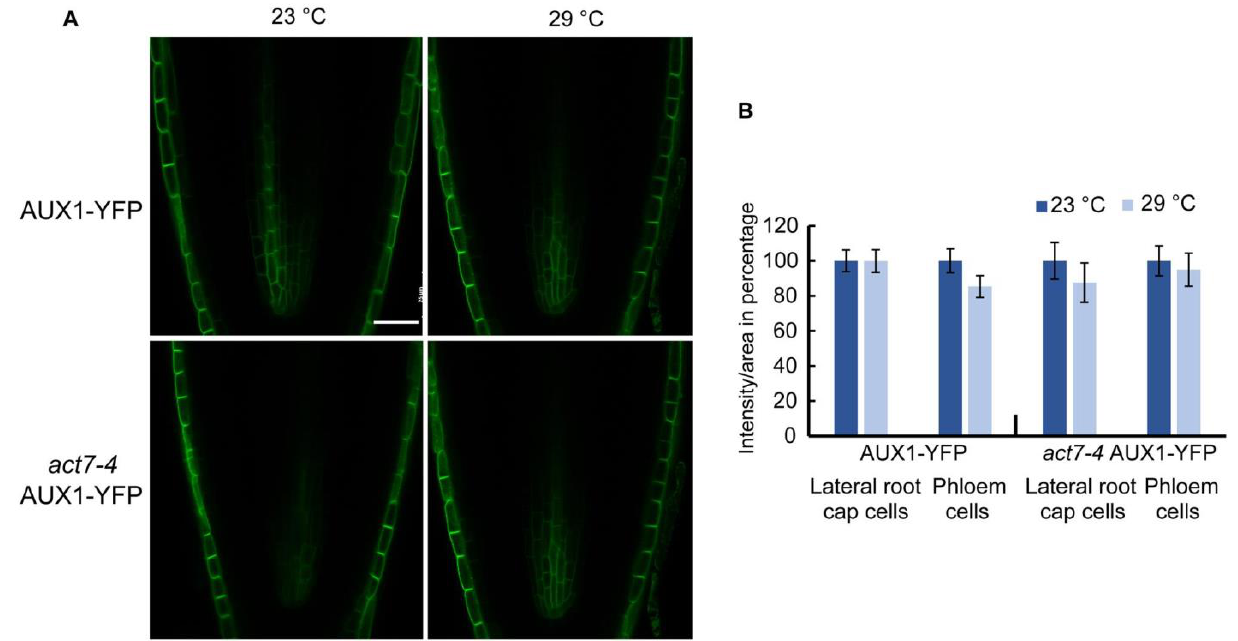
Figure 5. Prolonged high temperature does not alter AUX1 abundance in Col-0 and act7-4 mutants. ( A ) Cellular imaging of AUX1-YFP and act7-4 AUX1-YFP at 23 and 29 °C. Bar = 25 µm. ( B ) Quantification of GFP fluorescence intensity from ( A ). Five-day-old light grown seedlings of AUX1-YFP and act7-4 AUX1-YFP were transferred to new agar plates and subjected to high-temperature treatment (29 °C) for 72 h before imaged with confocal microscopy using the same confocal settings and are representative of 15 – 20 seedlings obtained from three independent experiments. Bar = 25 µm.